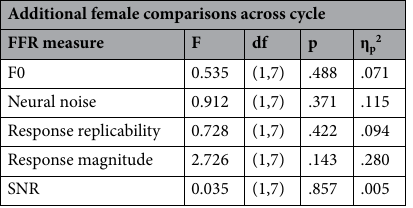
Table 2. RMANOVA results for female FFRs on remaining measures.